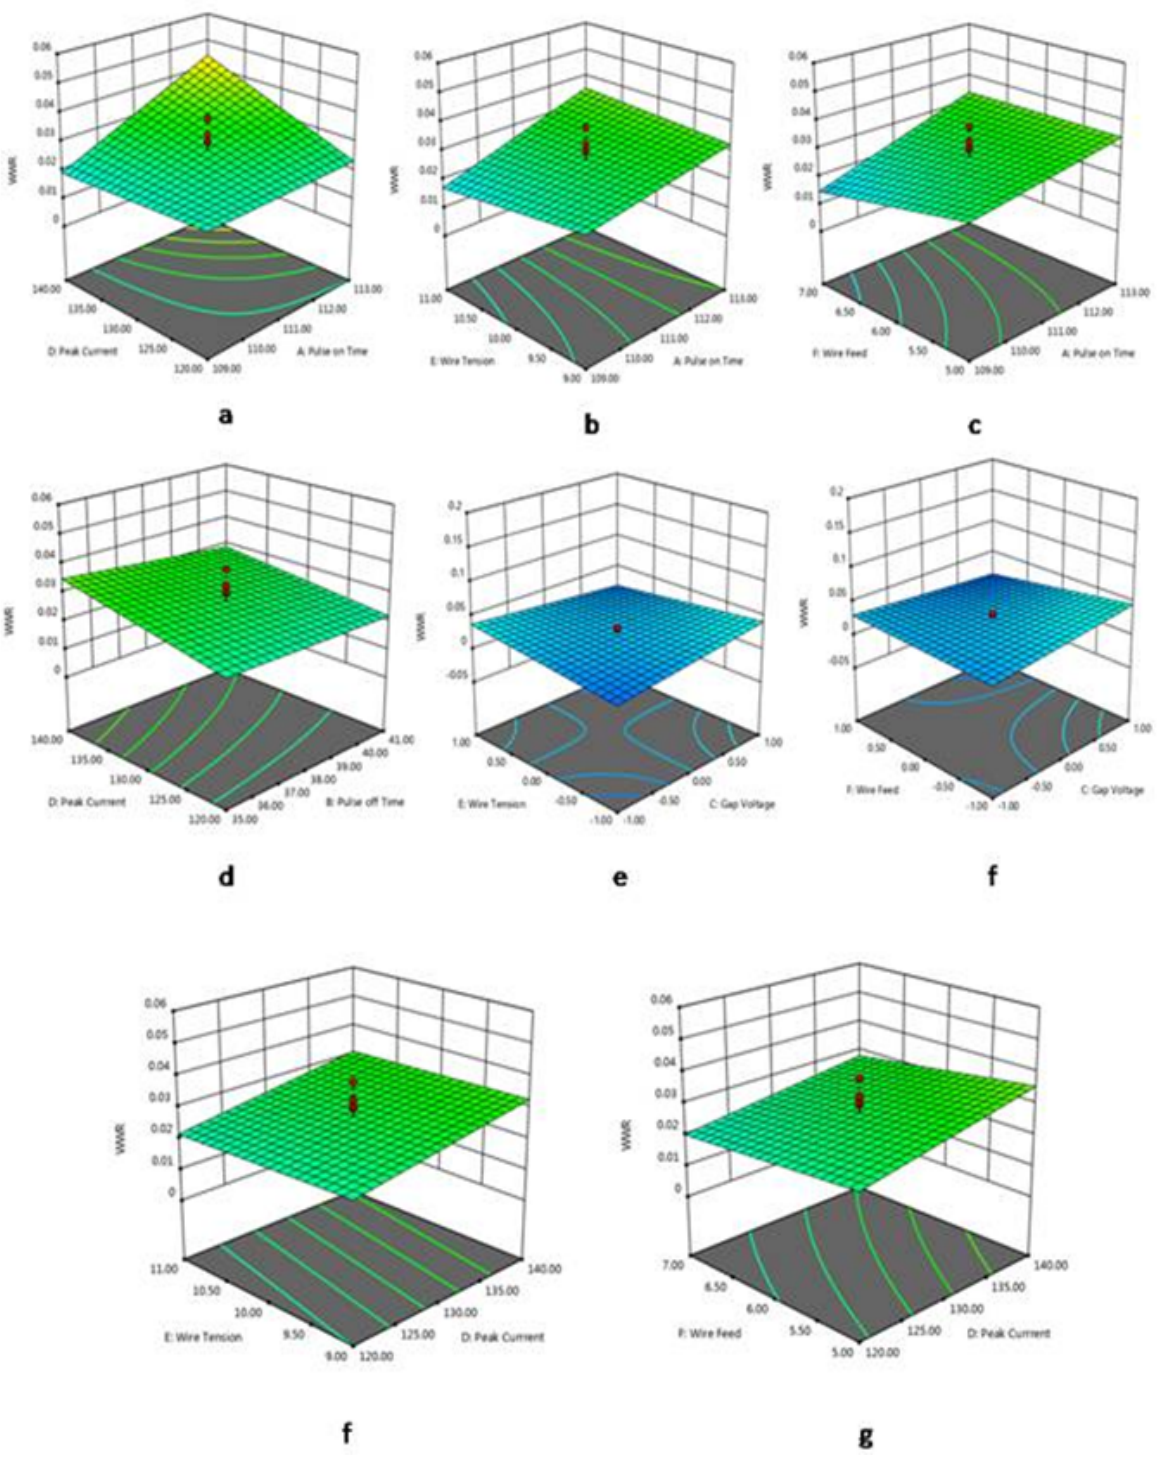
Figure 7: Three dimensional plot of combined effects of (A) pulse-on time and peak current (B) pulse-on time and wire tension (C) pulse-on time and wire feed (D) pulse-off time and peak current (E) gap voltage and wire tension (F), gap voltage and wire feed (G) peak current and wire tension (H) peak current and wire feed on WWR when other factors were kept